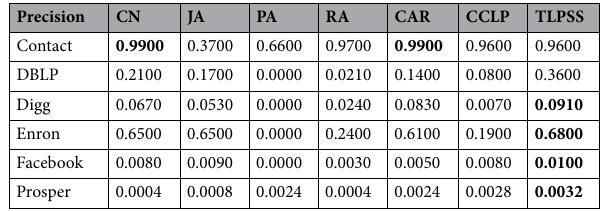
Table 5. Comparison of the Precision value between TLPSS and baseline methods. Significant values are in